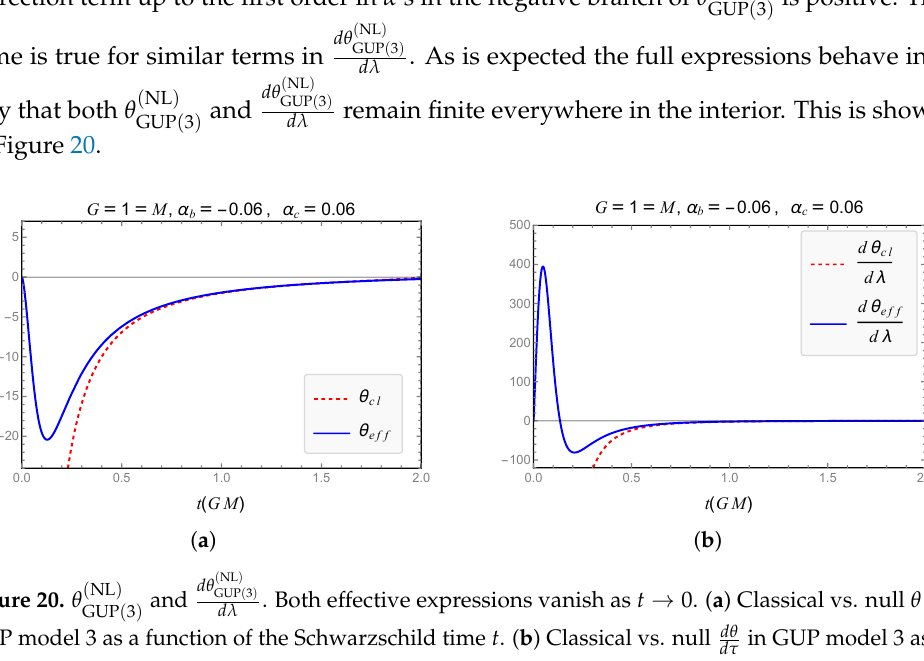
( NL ) is positive. The GUP ( 3 )